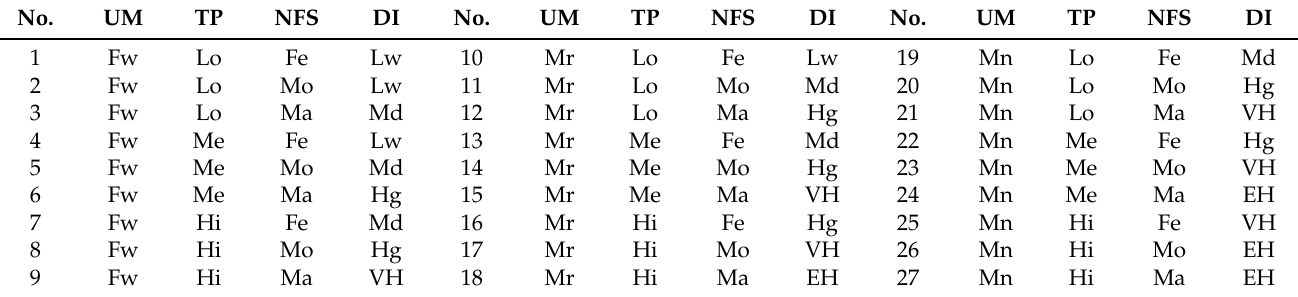
Table 1. FRB of FLC1.